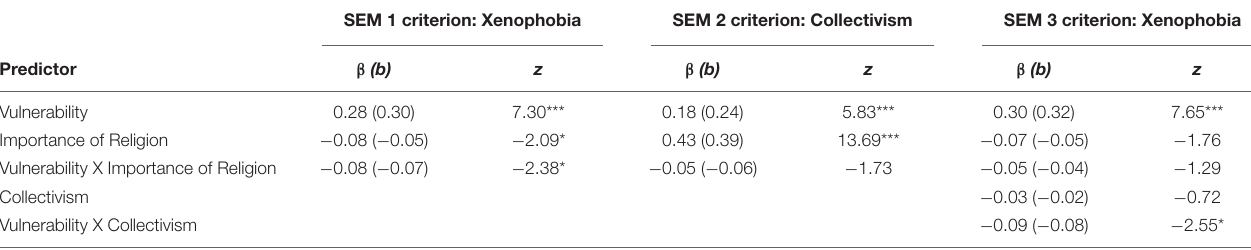
TABLE 3 | SEM results for mediated cultural